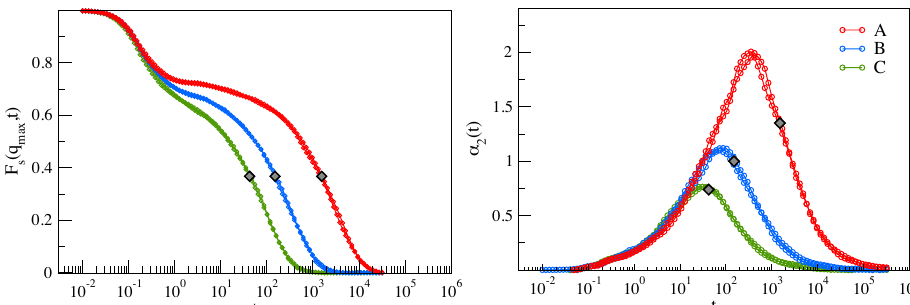
Figure 2. ( Left ) ISF from Equation (3) at q max , the first peak of the static structure factor. The curves refer to six states designed to have ISFs grouped into three distinct pairs, labelled as A, B, and C; see Reference [23] for details. In terms of structural relaxation time, density, and temperature ( τ α , ρ , T ) , each set is identified as A = { ( 42,1.01,0.47 ) , ( 42,1.05,0.6 ) } , B = { ( 150,1.01,0.435 ) , ( 150,1.03,0.49 ) } , C = { ( 1500,1.02,0.42 ) , ( 1500,1.05,0.51 ) } . ( Right ) NGP from Equation (4), of the same six states showing that their NGP group likewise. The relaxation time τ α is marked by a diamond in both